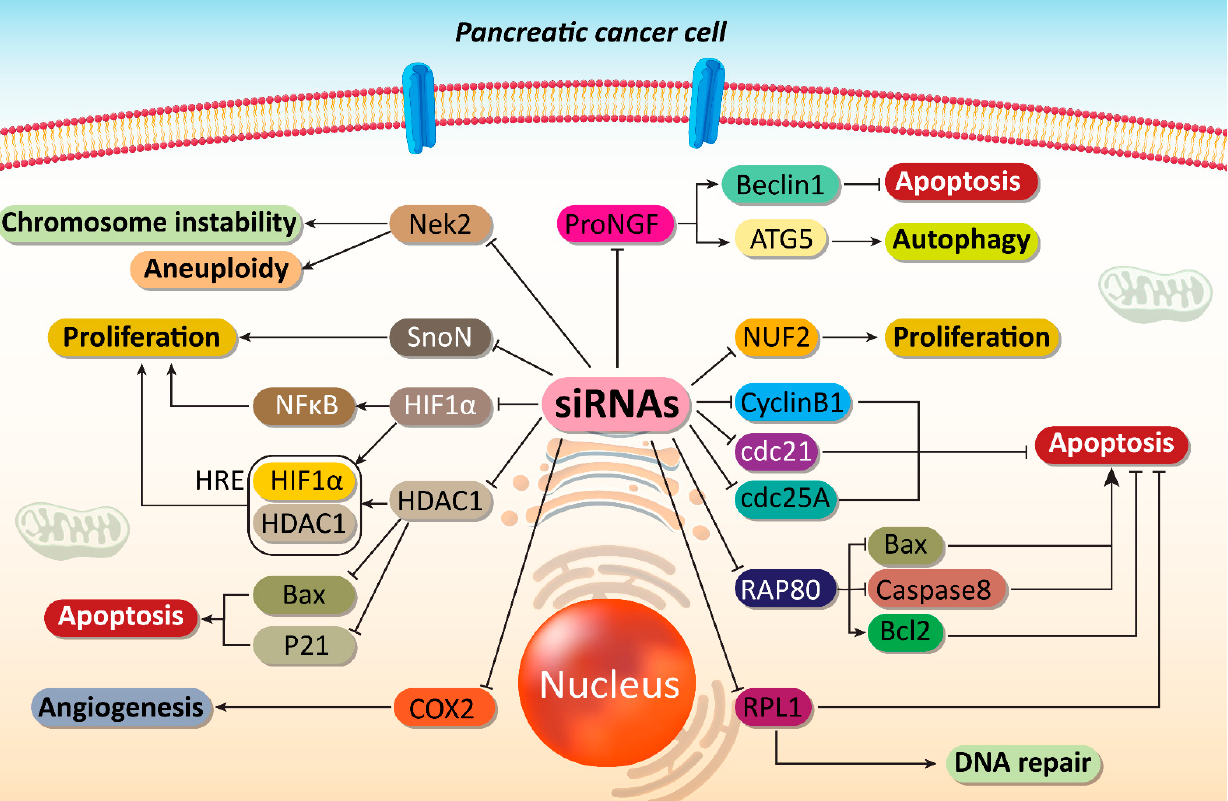
Figure 2. Impairing proliferation and angiogenesis of PC cells. Major molecular pathways can be targeted by siRNAs to induce apoptosis and DNA damage in PC cells. Moreover, angiogenesis responsible for PC progression can be suppressed by siRNAs in PC therapy. ProNGF, precursor of nerve growth factor; ATG, autophagy-related gene; COX2, cyclooxygenase-2; HDAC1, histone deacetylase 1; HIF-1 α , hypoxia inducible factor-1 α ; NF- κ B, nuclear factor-kappaB; siRNA, small interfering RNA; PC, prostate cancer.